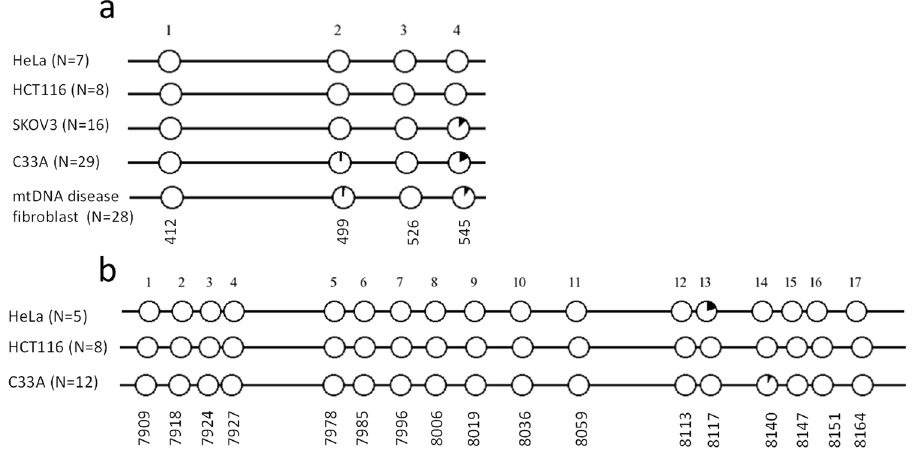
Figure 2. Bisulfite sequencing of mtDNA. Bisulfite sequencing of a region in the D-loop (H-strand) ( a ) and mtCOX2 gene (L-strand) ( b ) for SKOV3, skin fibroblasts of a mtDNA disease patient (only in a ) HeLa, HCT116 and C33A cells ( a , b ). Each circle represents a single CpG position, the percentage of black of each circle represents the percentage of